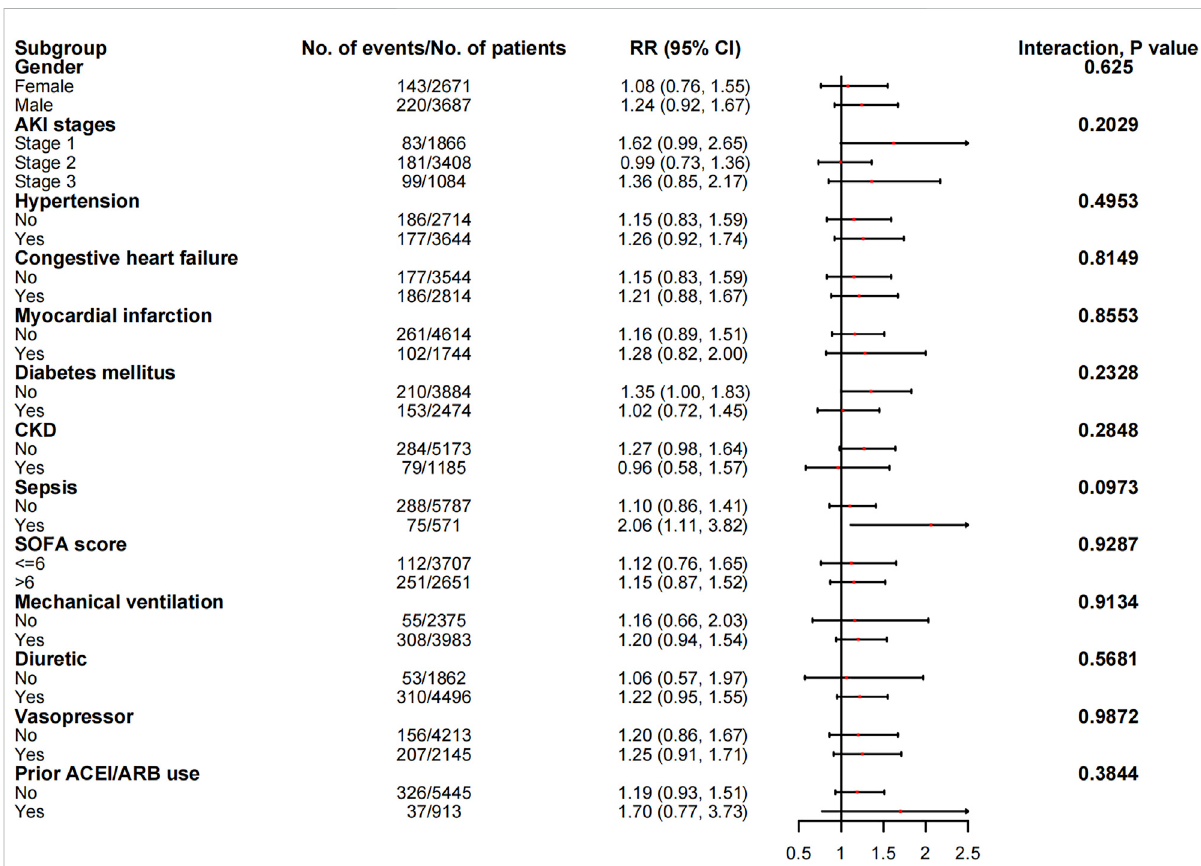
FIGURE 7 The association between ACEI/ARB use and hyperkalemia in subgroups. Abbreviations: AKI, acute kidney injury; ACEI, angiotensin-converting enzyme inhibitor; ARB, angiotensin receptor blocker; CI, con fi dence interval; CKD, chronic kidney disease; RR, risk ratio; SOFA, sequential organ failure assessment